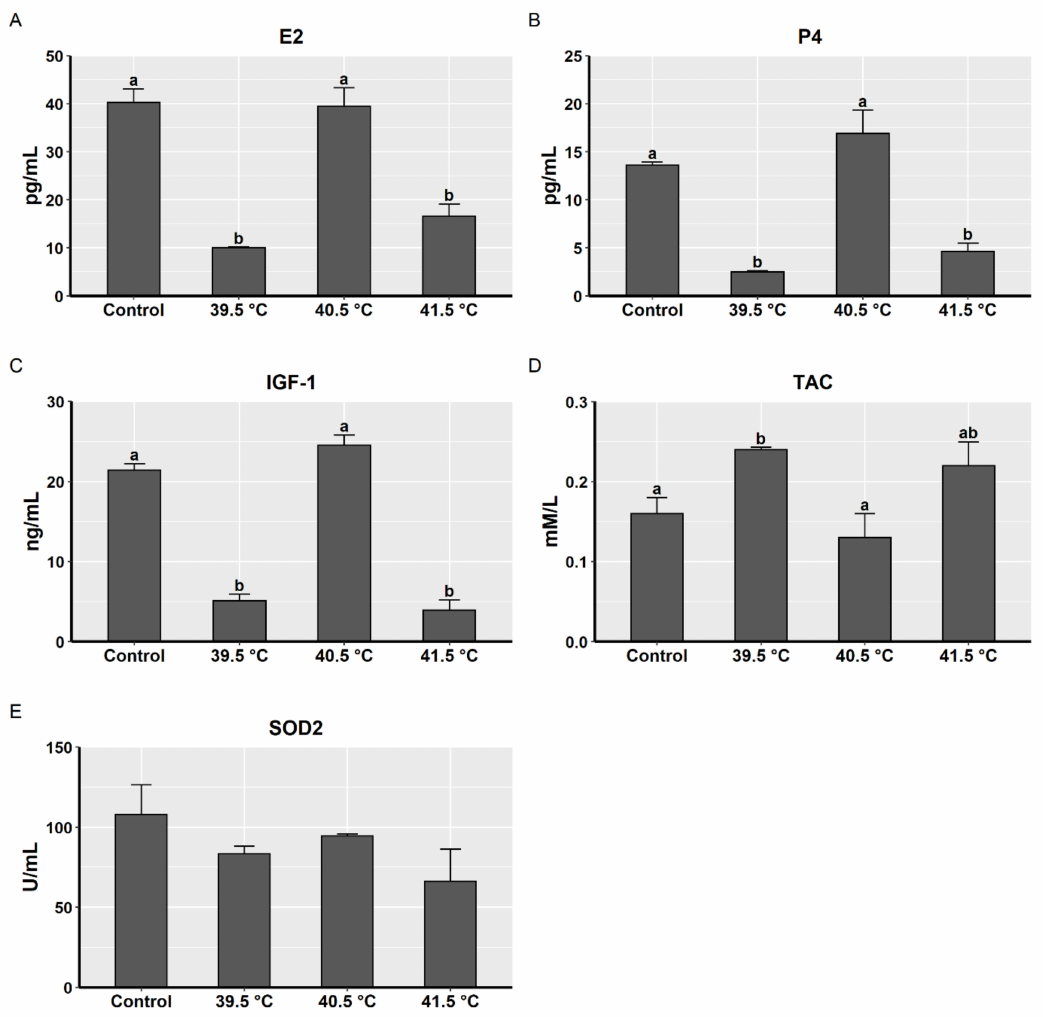
Figure 2. Steroid concentrations and enzymatic activities of buffalo granulosa cells post-heat treatment (39.5 ◦ C, 40.5 ◦ C, or 41.5 ◦ C for the last 24 h of culture, 7 days) in comparison to control group (37 ◦ C); ( A ) E2 (estradiol-17 β , pg/mL), ( B ) P4 (progesterone, pg/mL), ( C ) IGF-1 (insulin-like growth factor 1, ng/mL), ( D ) TAC (total antioxidant capacity, mM/L), and ( E ) SOD2 (superoxide dismutase 2, U/mL); data are presented as mean ± SEM; bars with different letters indicate differences ( p < 0.05); and data from three biological